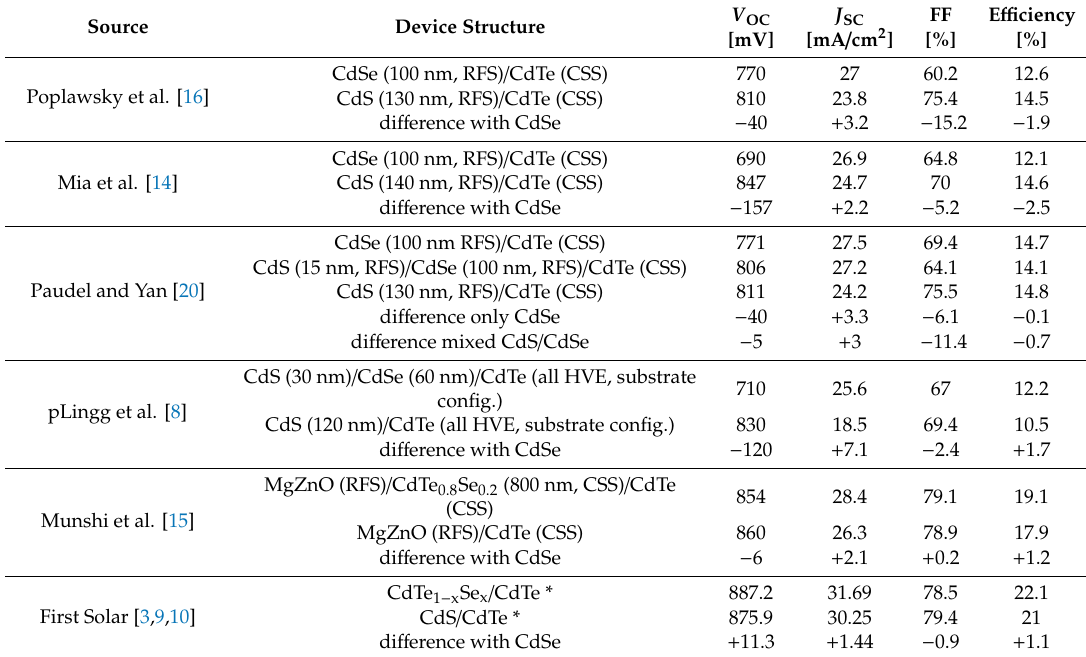
Table 3. J - V parameters of devices containing CdSe compared with non-CdSe devices. Deposition (high vacuum